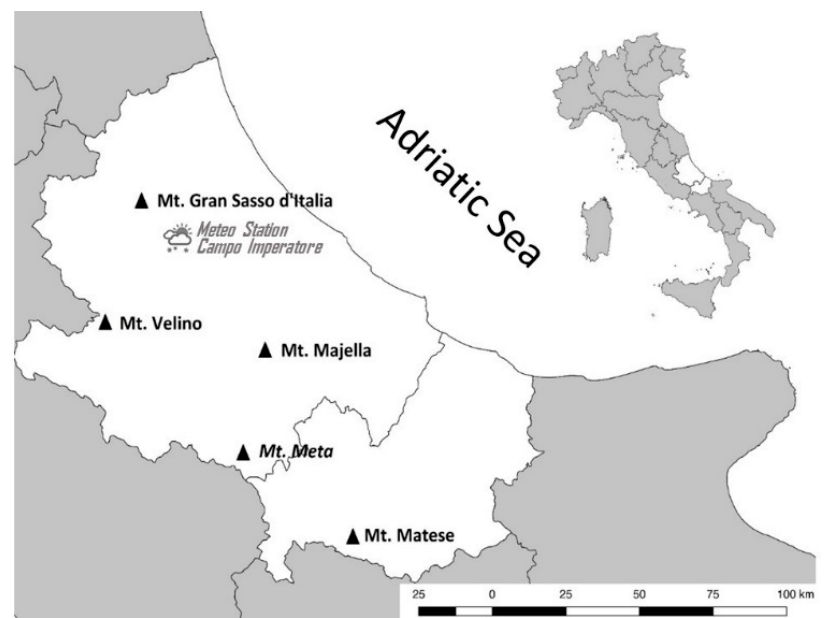
Figure A1. Location of the study area and the mountain massifs of the Central Apennines (Abruzzo and Molise Regions in white).